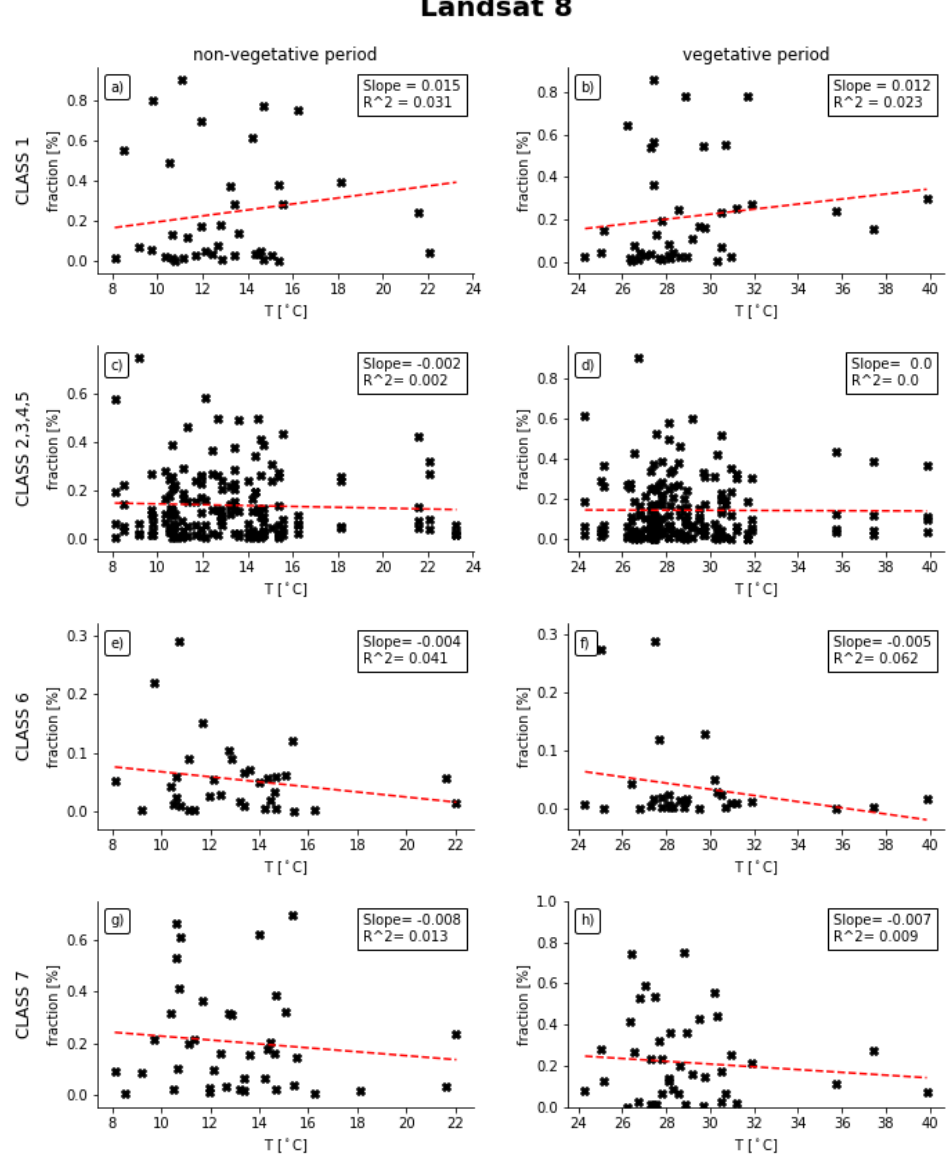
Figure 8. LCZ class fractions [%] computed into the 500 m buffer around the stations versus the measured air temperature at the stations. Air temperature measurements correspond to the hour of the Landsat 8 imagery acquisition. Acquisition times are 18 March 2016 (non-vegetative period) and 22 June 2016 (vegetative period) both at 10:10 am GMT. Red Lines and text boxes show the results of the linear regression for each